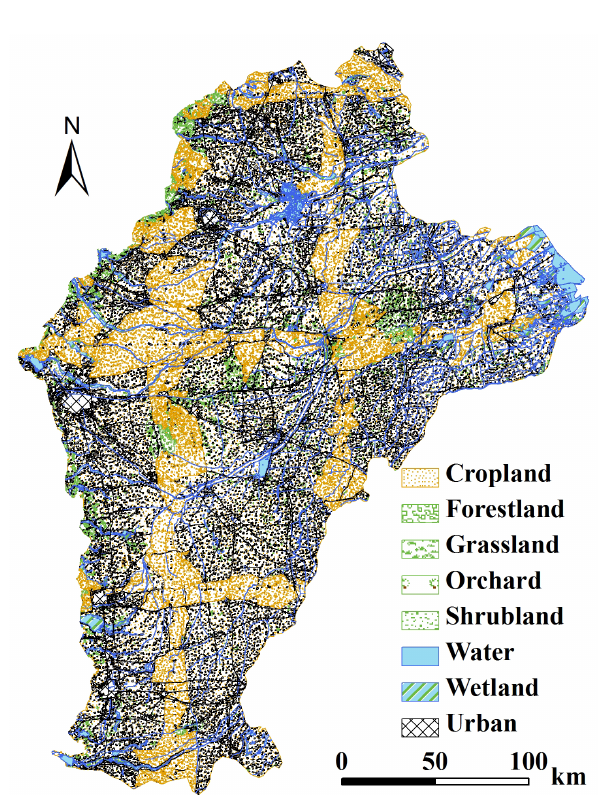
Figure 2. Land-use map of the Hebei southern